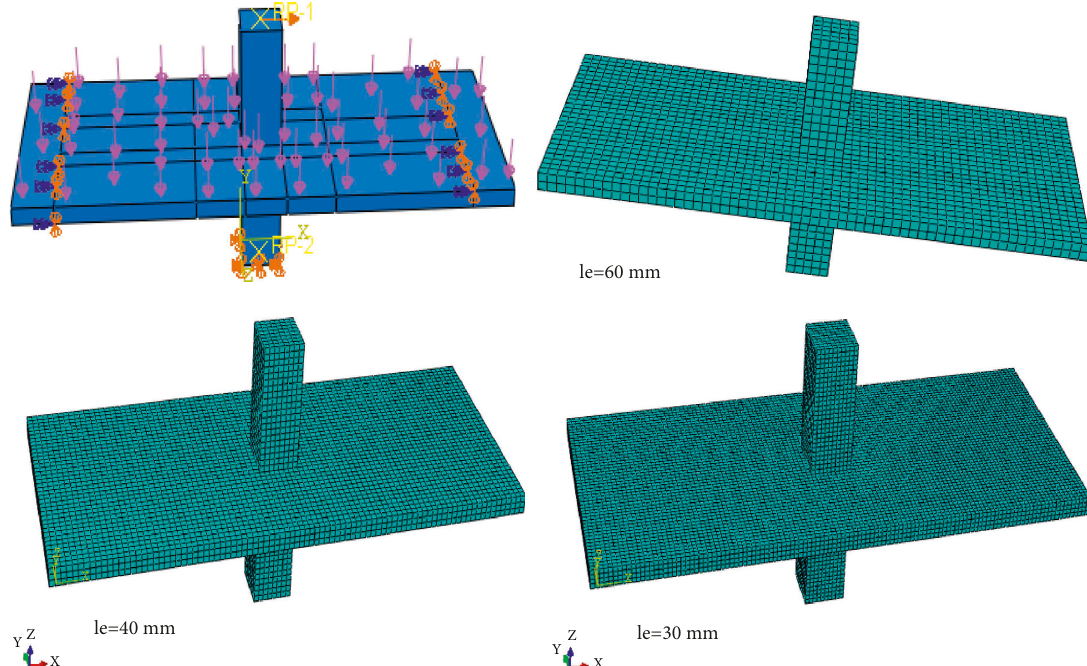
Figure 6: Loading, boundary condition, and meshing of the models with different sizes.